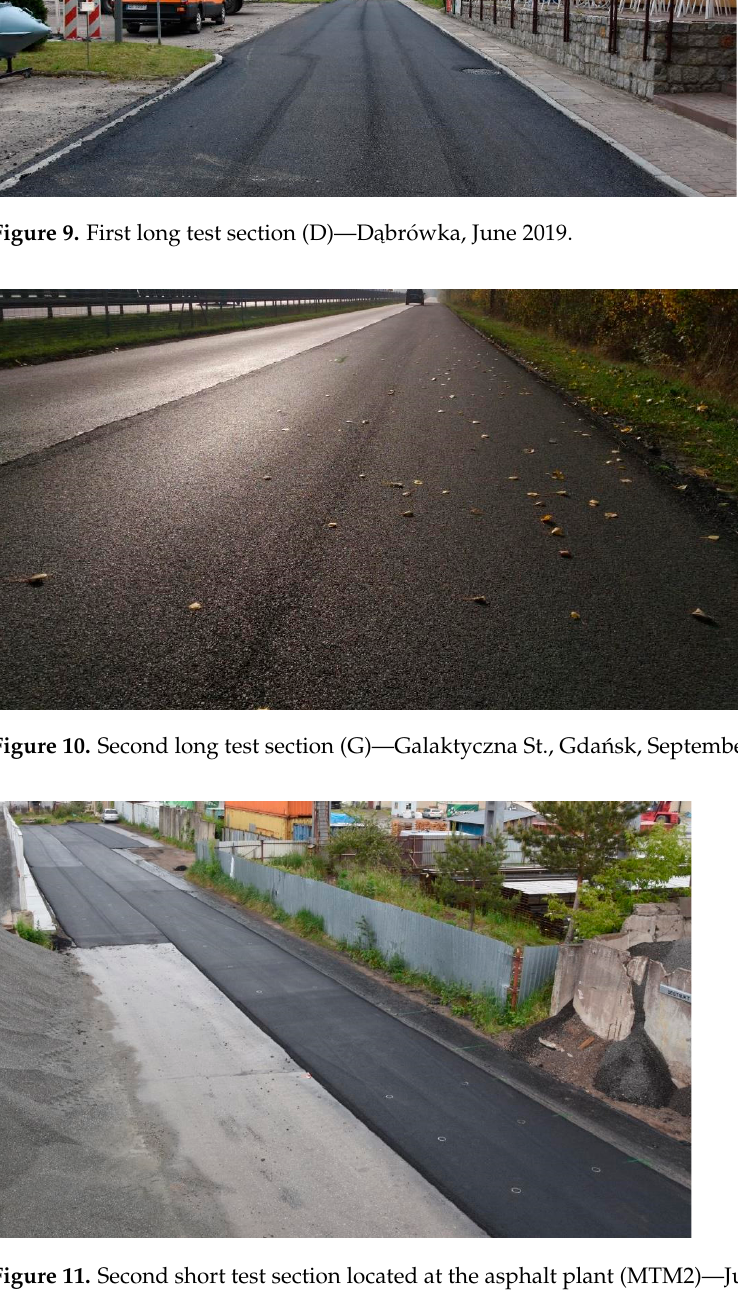
Figure 12. Third, final long test section (K)–Spokojna St., Kartoszyno, September 2020. Core samples were taken from each test section for laboratory testing. Depending on the purpose, cores with a diameter of 100 or 150 mm were taken. Void content, shear strength, and interlayer bonding were assessed according to the methodology described in Section 3.3. A summary of the test results for samples cored out from tests sections are presented in Figures 13–15.